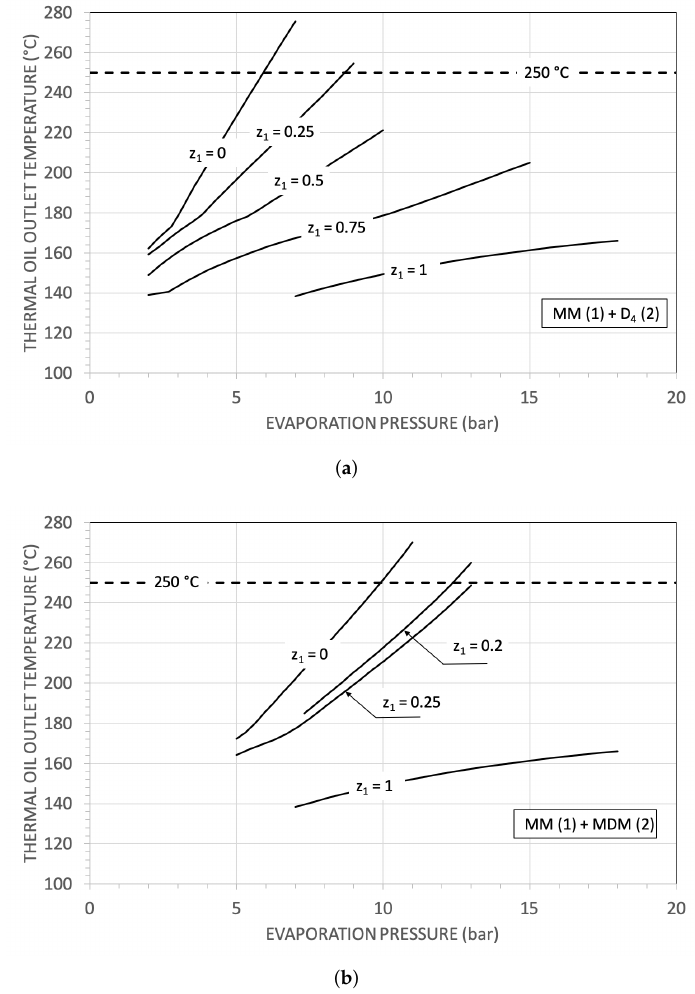
Figure 13. Thermal oil outlet temperature from the heat recovery heat exchanger as a function of the evaporation temperature and for different mixture compositions, for ( a ) a mixture of MM and D 4 and ( b ) a binary mixture of MM and